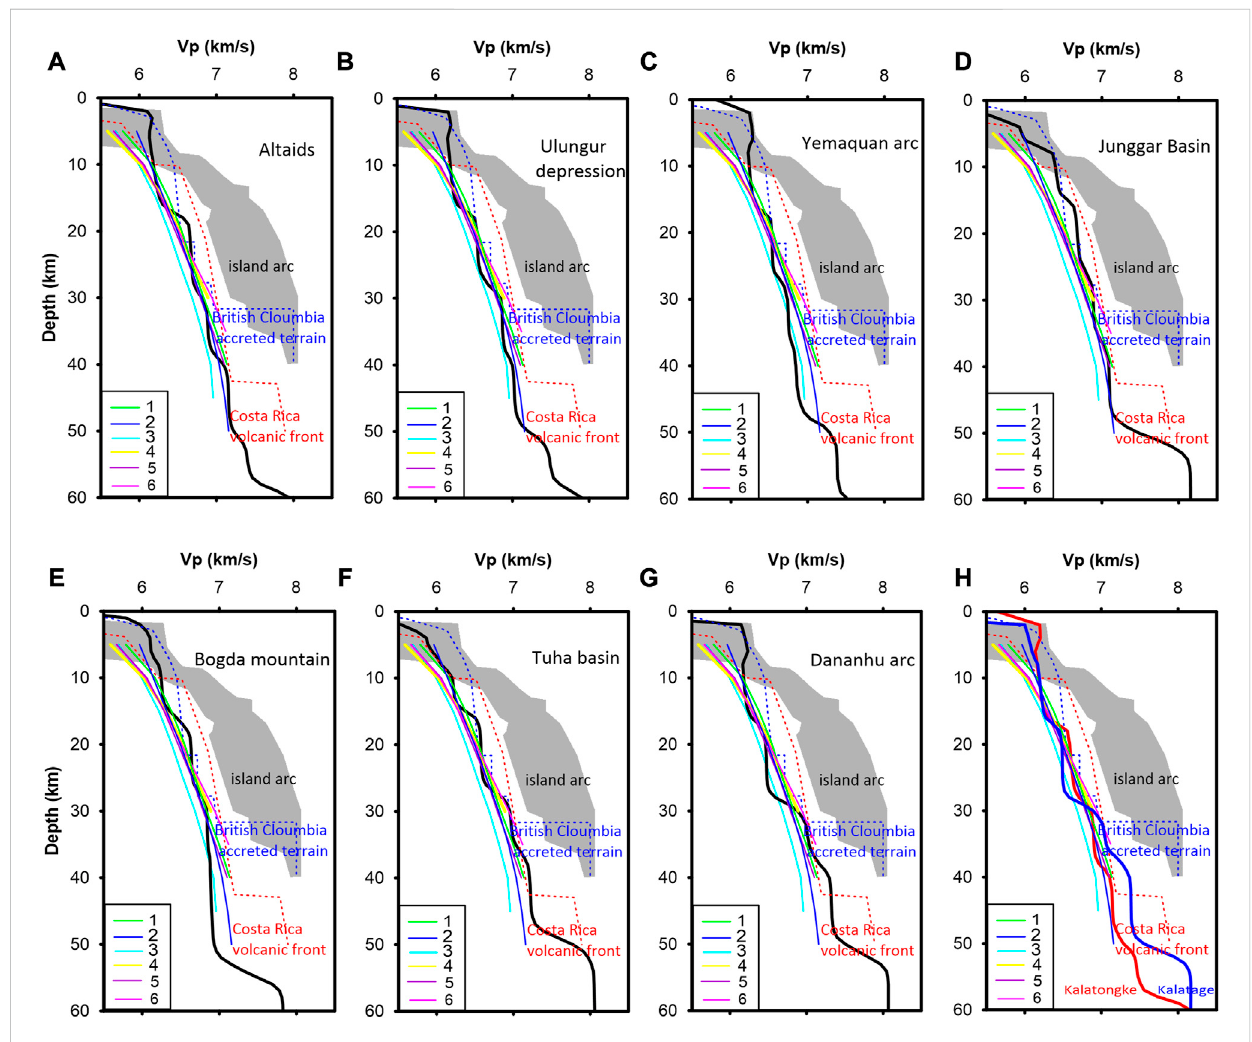
FIGURE 7 (A − G) P-wave velocity curves versus depth for eachof thedistinct blocks crossed bythereferencepro fi le(thick black lines) comparedto thecurves deduced for other regions. (H) Same for Kalatongke (thick red line) and Kalatage (thick blue line) mining areas. Velocity-depth curves for other tectonic provinces (Christensen and Mooney, 1995): 1, continental arcs; 2, global average for continent; 3, orogens; 4, extended crust; 5, shields and platforms; 6, rifts. The grey shaded area represents the range of velocities inferred in island arcs from wide-angle seismic surveys (Calvert,